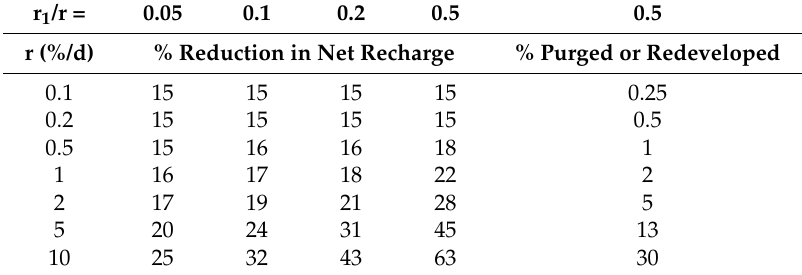
Table 4. Percentage reduction in net recharge as a result of clogging for one set of operational parameters. Notably α = 0.8, η = 0.1, V p1 = 1.2 * q 0 * 20 min and V p2 = 3000 m 3 with three days of lost injection. In each case the dominant reduction in net recharge was due to a reduced injection rate. The volume of water purged or redeveloped is shown for the highest ratio of chronic to acute clogging. r 1 /r